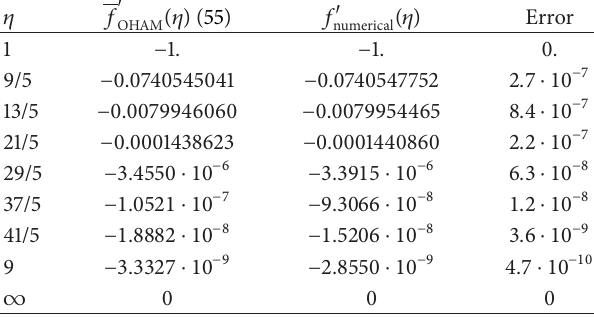
Table 13: Comparison between the derivative 𝑓 (55) and numerical results for 𝛾 = 2 and 𝑆 = −2 (error = |𝑓 (𝜂)| ). 𝑓 󸀠 numerical